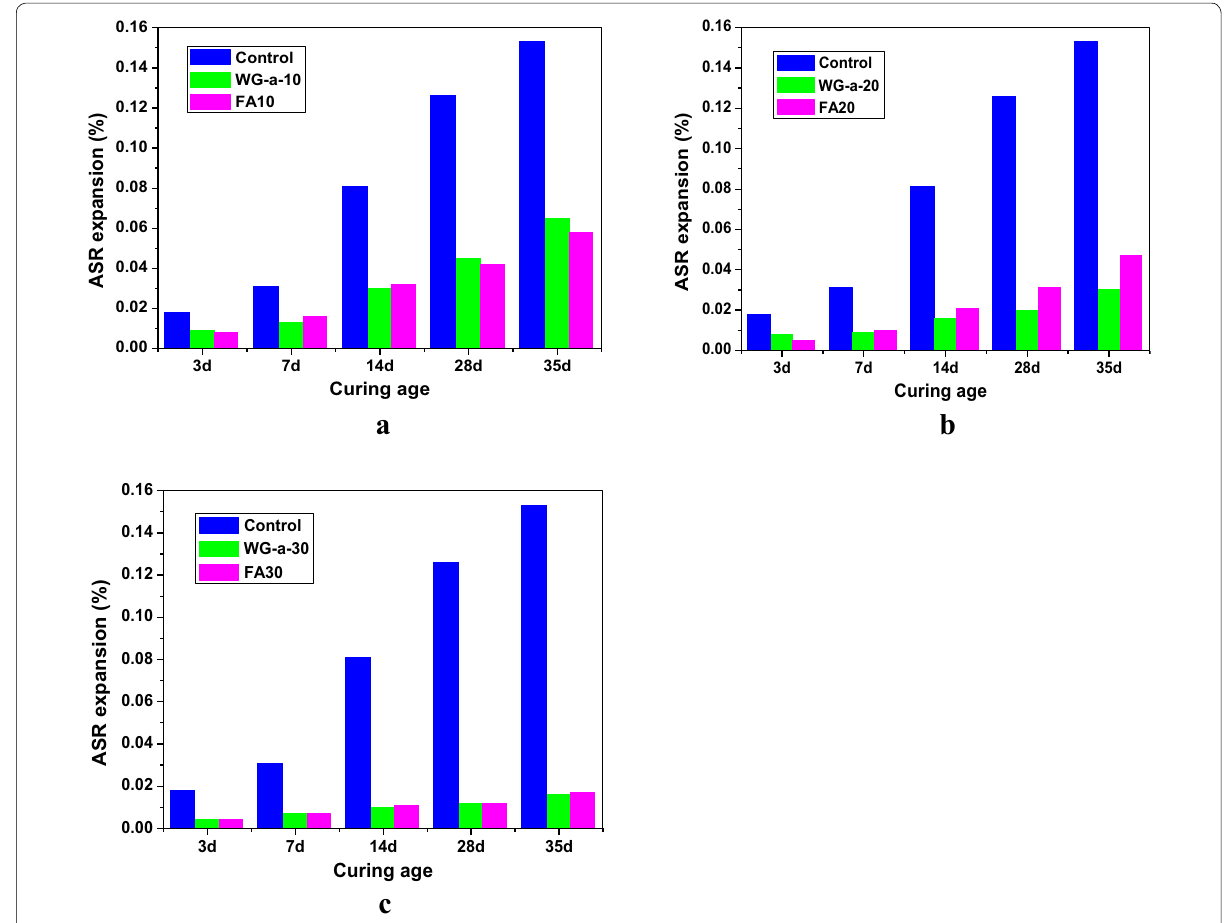
Fig. 5 ASR expansions of cement mortar bars incorporating waste glass powder (38–53 μm) and fly ash with different replacement ratios. a Replacement ratio of 10%, b replacement ratio of 20%, c replacement ratio of